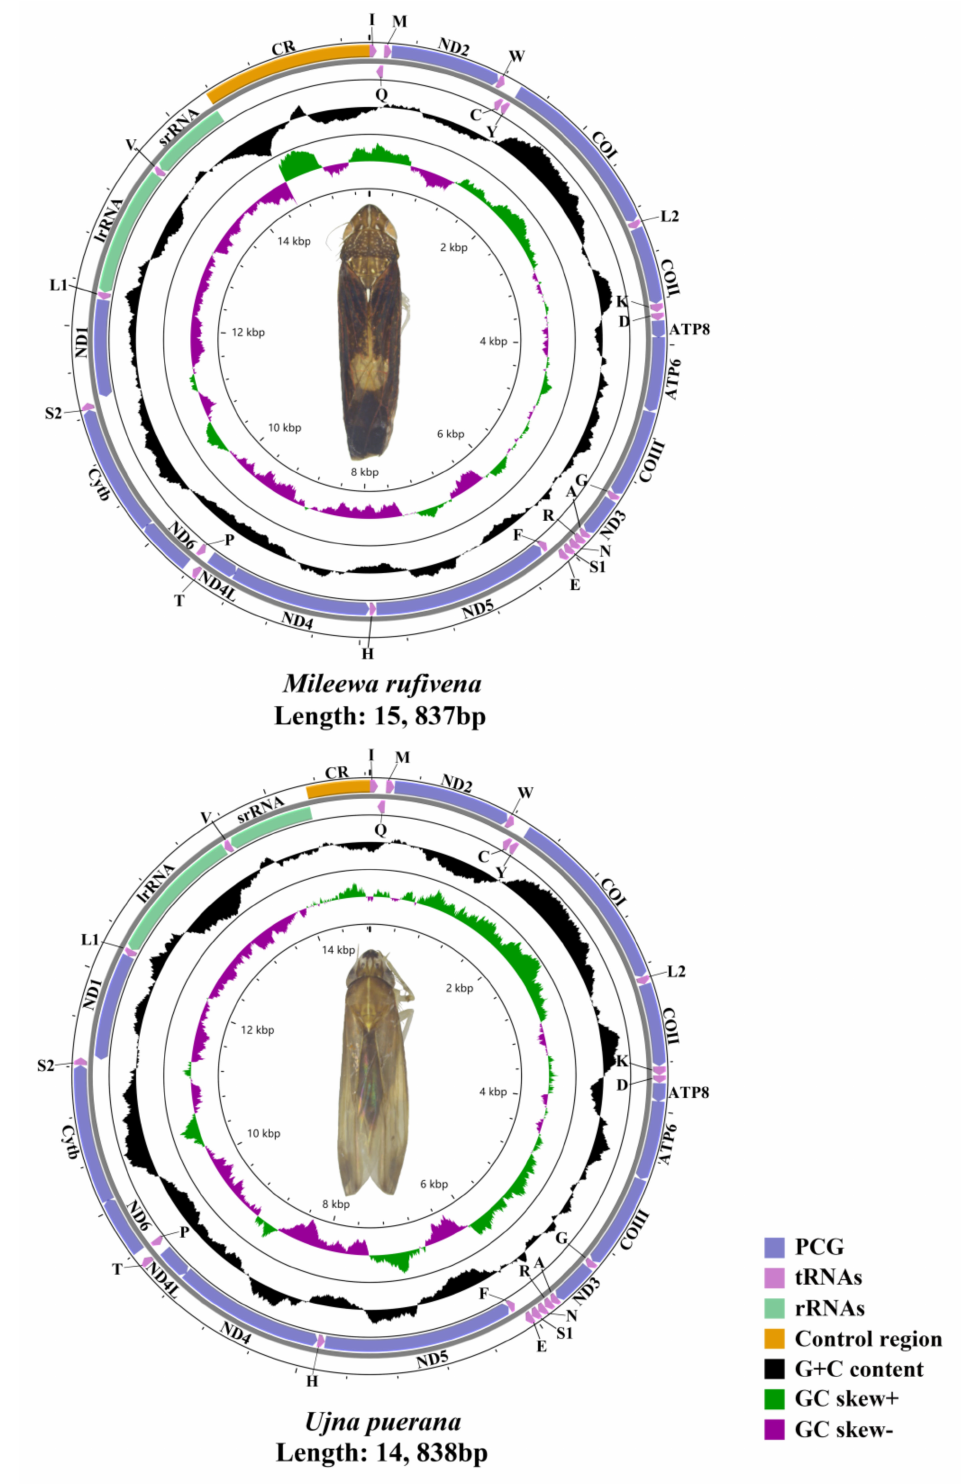
Figure 1. Circular maps of the mitogenome of Mileewa rufivena and Ujna puerana